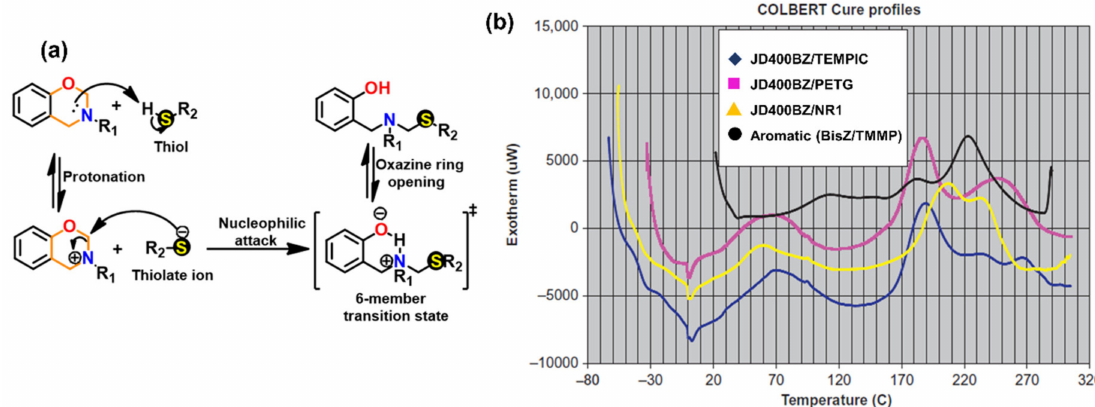
Figure 38. ( a ) Proposed COLBERT reaction mechanism and ( b ) DSC comparisons of aliphatic vs aromatic benzoxazine/thiol polymerization profiles [276]. Copyright 2011. Reproduced with permission from Elsevier B. V.